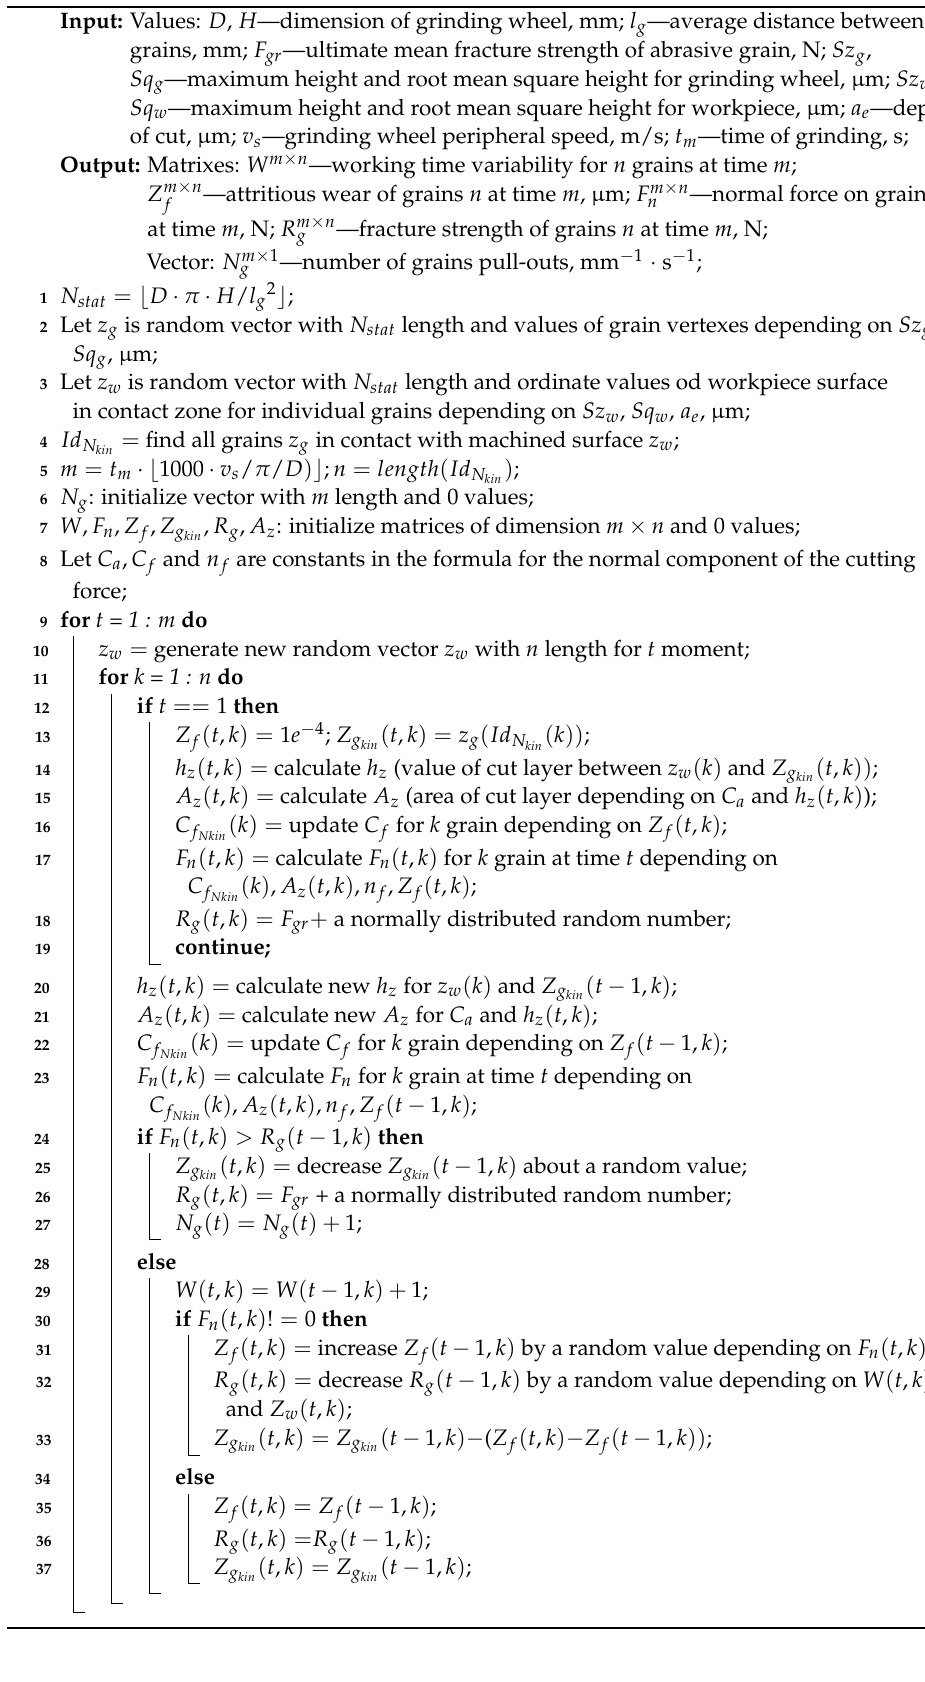
Algorithm 1: Algorithm to analysis of abrasive grains wear